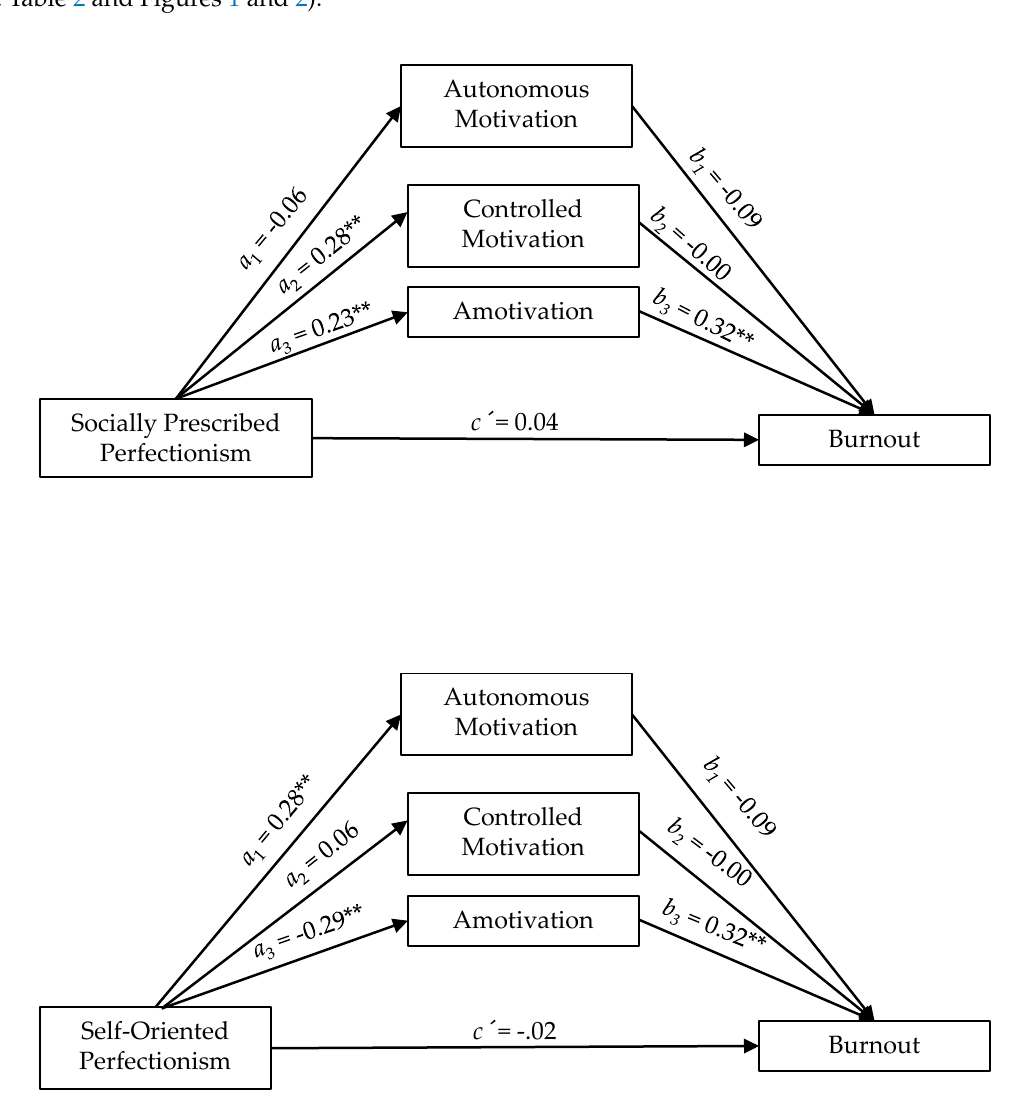
Figure 1. Graphic representation of forms of motivation as mediators between socially prescribed perfectionism and self-oriented perfectionism with burnout. ** p < 0.01; † p < 0.10.